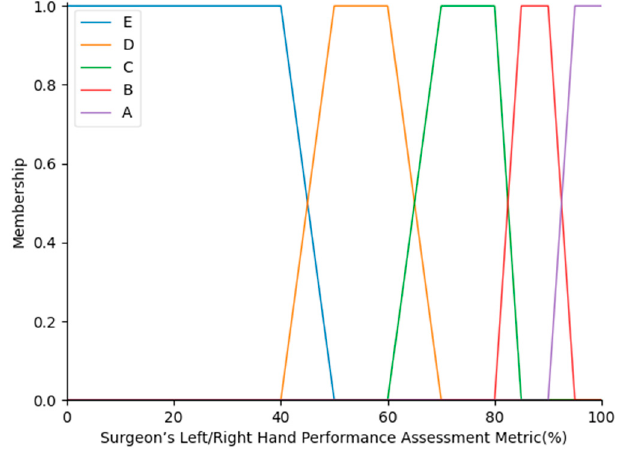
Figure 7. Output variable MFs for surgeon’s performance assessment for the right and left-hand movements in the first level.